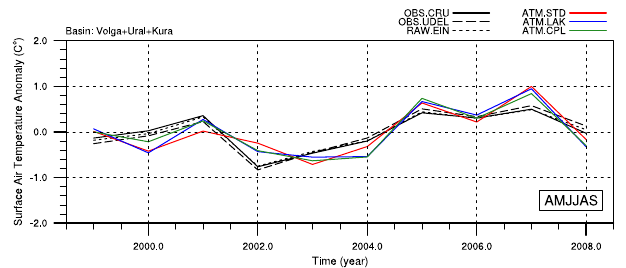
Fig. 5. Anomalies of warm season (from April to September) sur- face air temperature ( ◦ C) for the period 1999–2008 in the model simulations and the different observation datasets. The domain only includes the Volga, Kura and Ural basins shown in Fig. 3a (extracted from the Total Runoff Integrating Pathways, or TRIP, dataset).